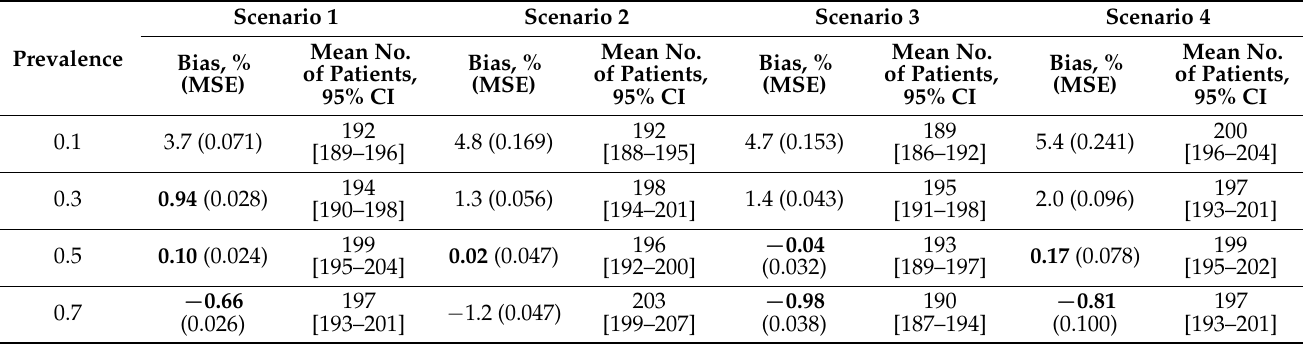
Table 3. Bias, mean squared error (MSE), and mean number of patients (95% CI) of cut-off points derived by the heuristic algorithm